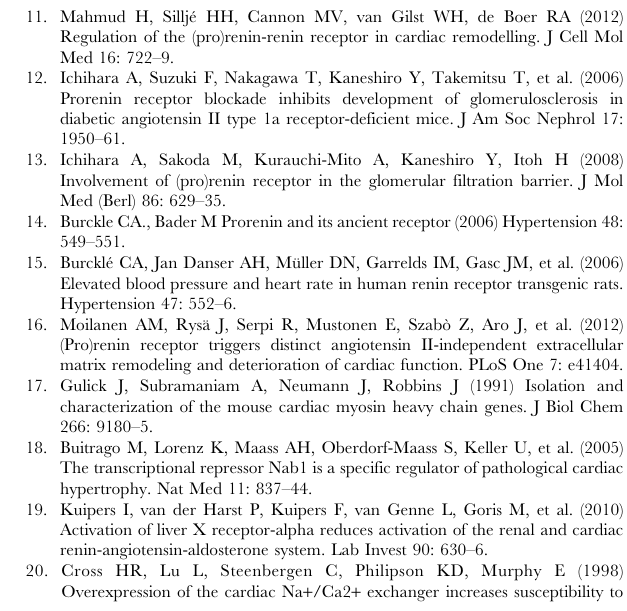
Table S2 Echocardiographic data and blood pressure measure-